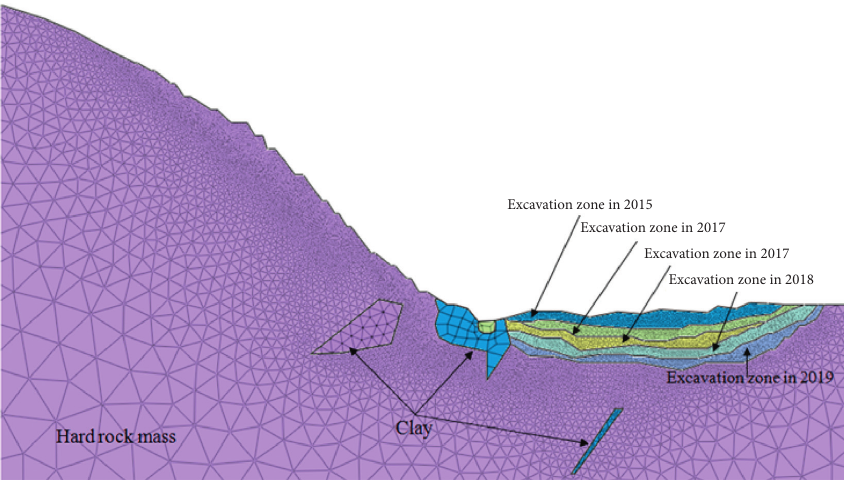
Figure 13: FEM meshes in terms of excavation yearly, in blue dotted rectangle in Figure 8(b).